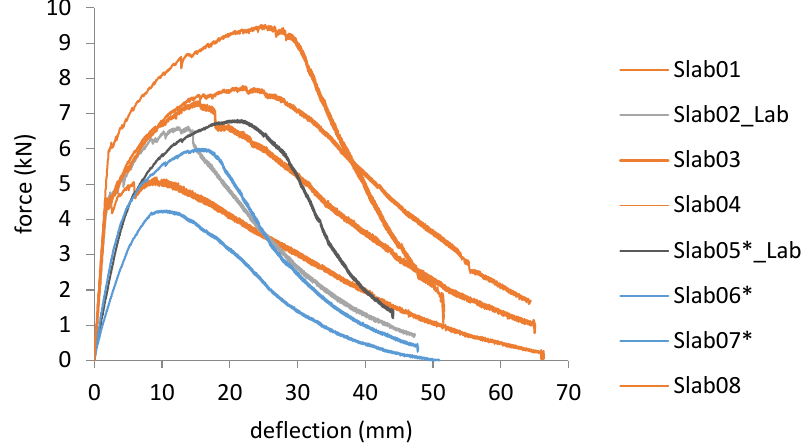
Figure 12. Load–deflection curves (* damaged; _Lab: cast in the laboratory).